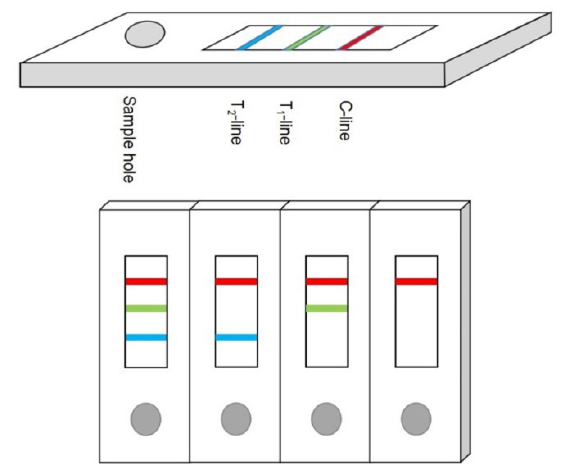
Figure 1. Schematic diagram of test strip structure and test results. Results of test strips in dif- ferent spice bases are shown in Table 2 and Figure 2. When the mycotoxin concentration was 0 μ g/kg, the two T lines showed a deep red color. When the concentration of AFB 1